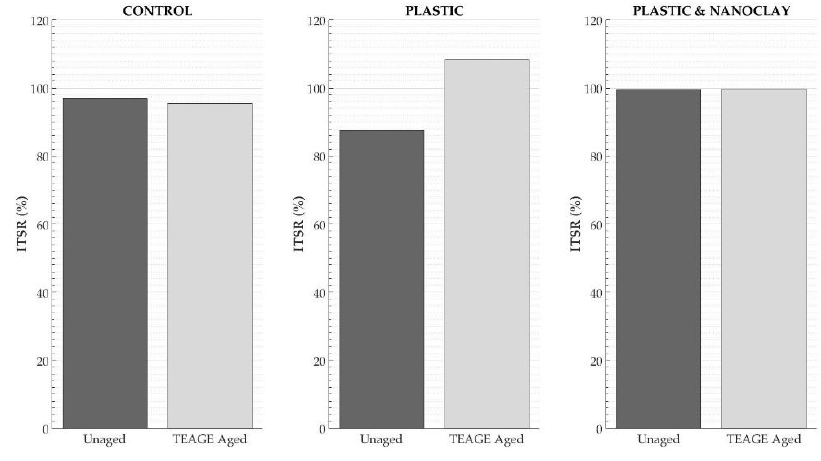
Figure 7. Indirect tensile strength ratio (ITSR) values.